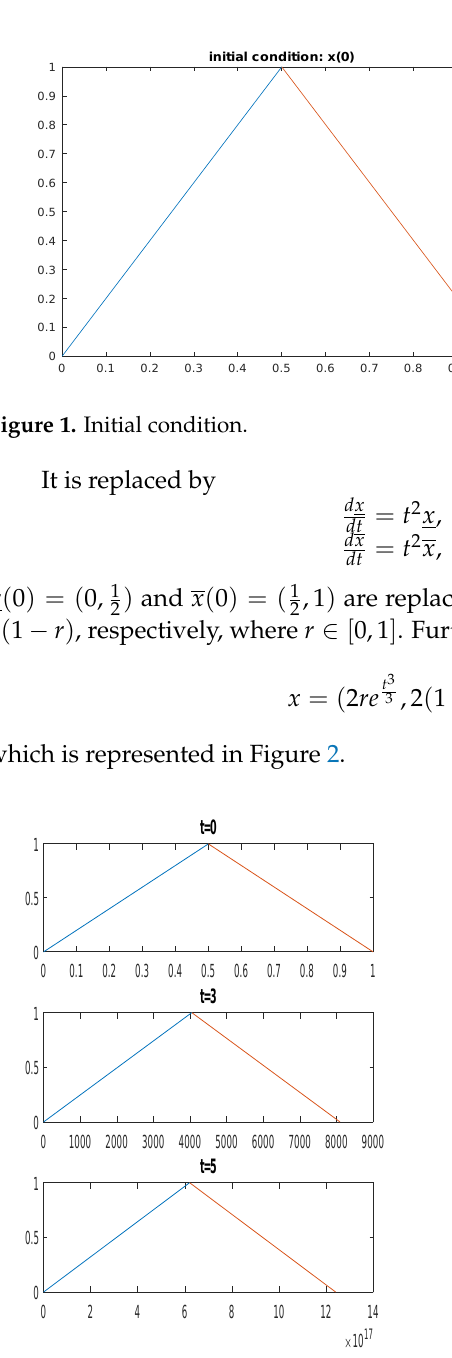
Figure 2. Line graph for the